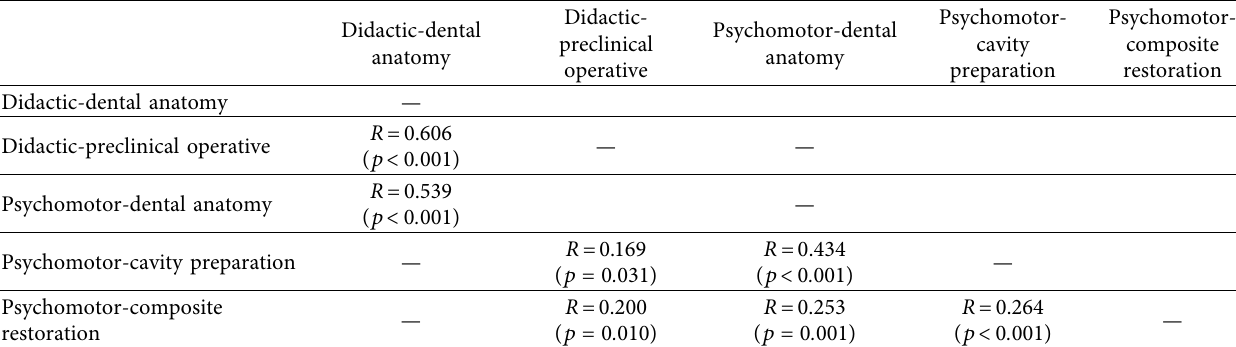
Didactic- Psychomotor- Psychomotor- Didactic-dental Psychomotor-dental preclinical cavity composite anatomy anatomy operative preparation restoration